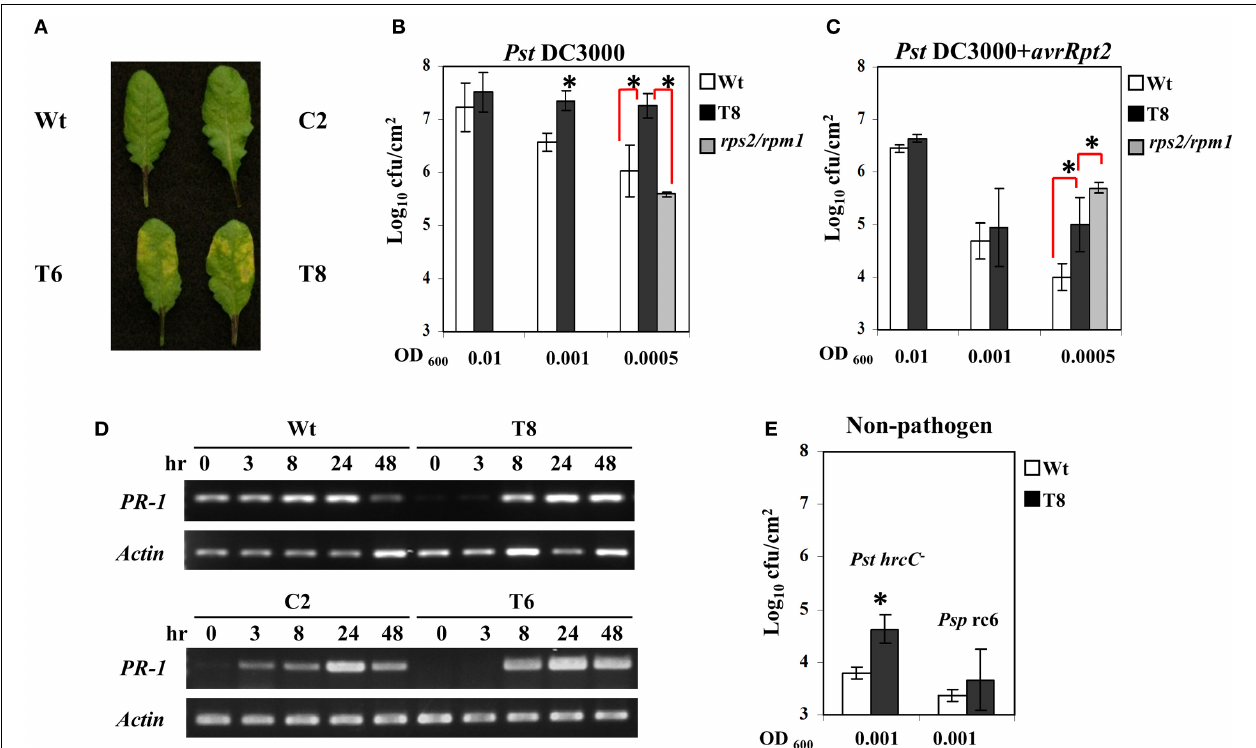
Pst DC3000 + avrRpt2 (OD 600 = 0 . 001, 7 × 10 5 cfu/ml). RT-PCR was carried out with gene-specific primers for PR-1 and Actin . (E) For bacterial growth counts taken at day 4 after inoculation with the two non-pathogens, Pst DC3000 + hrcC- ( Pst hrcC- ) and P. syringae pv. Phaseolicola race 6 ( Psp rc6 ), the concentration of inoculants were OD 600 = 0 . 001 (7 × 10 5 cfu/ml). Plant lines used were Wt (white), T8 (black), and the rps2/rpm1 double knock-out mutant (gray). ∗ P < 0 .